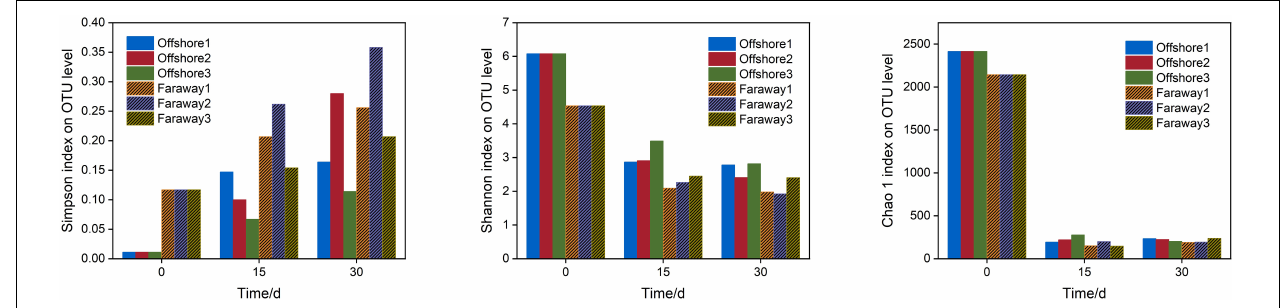
FIGURE 8 | Bar charts for alpha diversity, including Simpson, Shannon, and Chao 1 indexes of community on the initial day, 15 and 30 days (Offshore represents the distance of 0.2 km from shore. Faraway represents the distance of 5 km from shore).